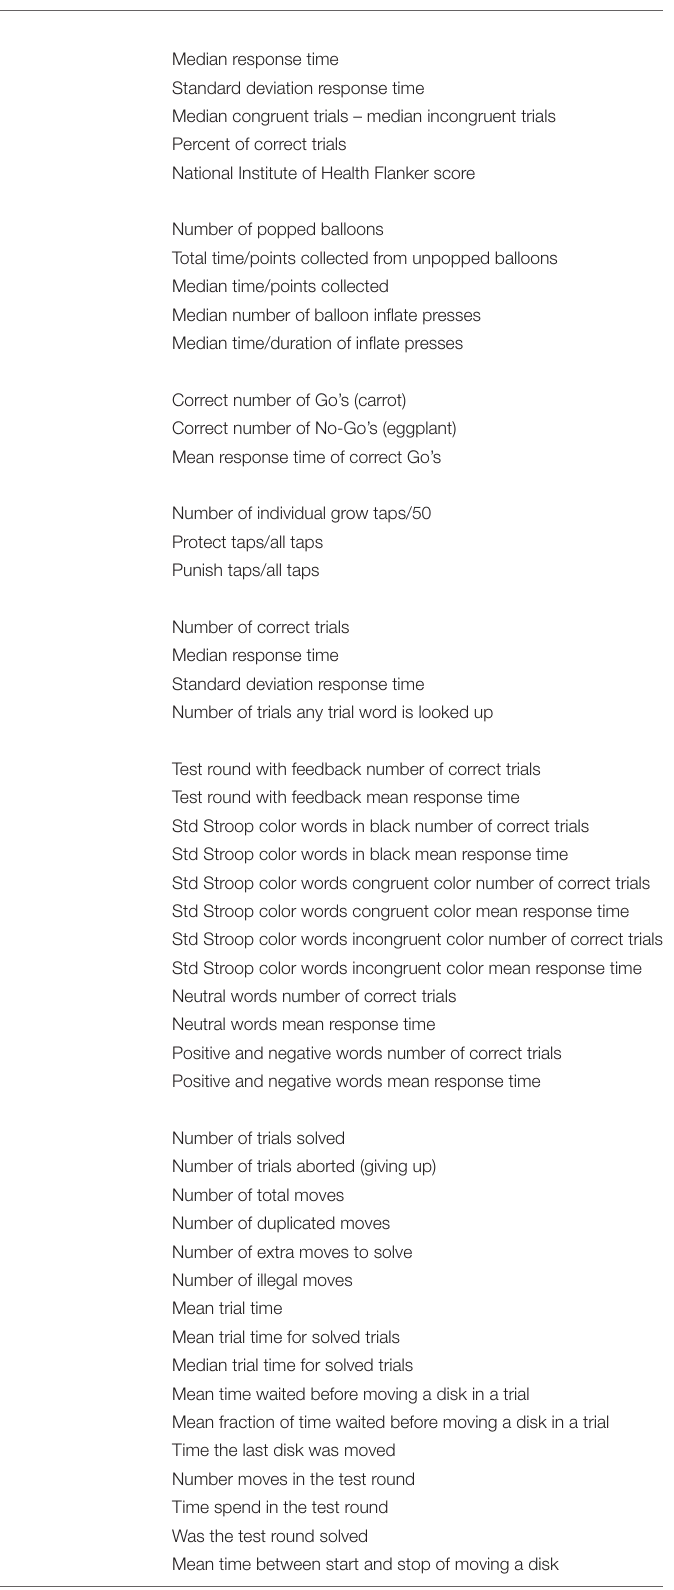
TABLE 5 | Definitions of the machine learning features used in each NCRA test.